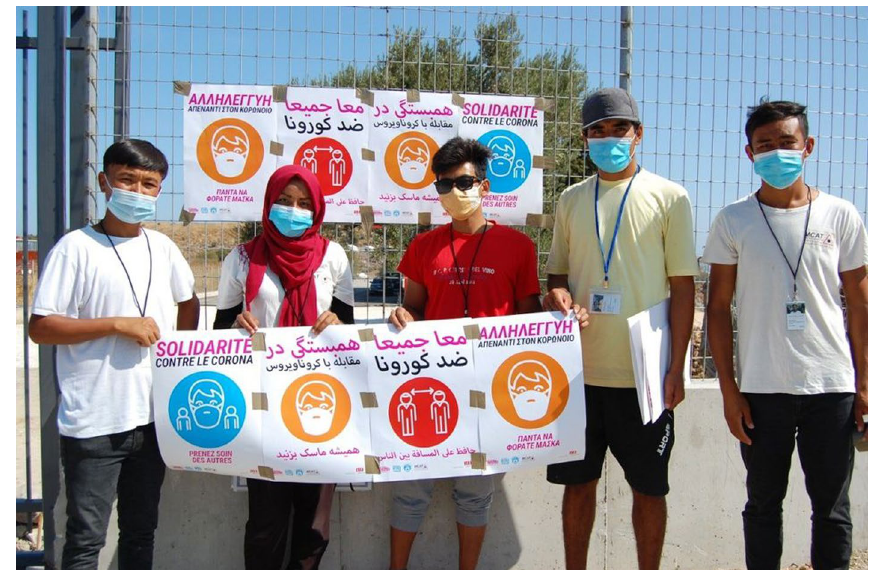
Fig. 1 Moria Coroan Awareness Team; Copyright MCAT 2020; photographer Amanullah